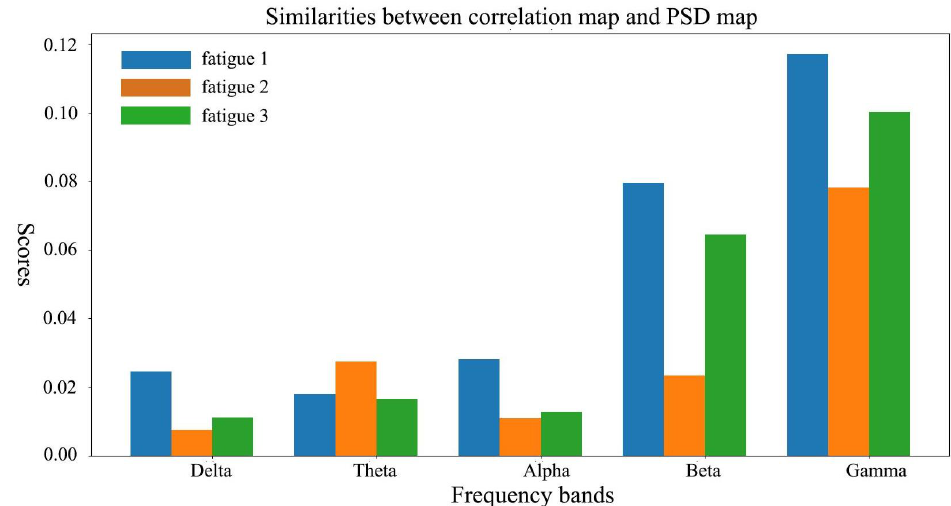
Figure 6. Similarities between correlation map and PSD map for different fatigue levels and frequency